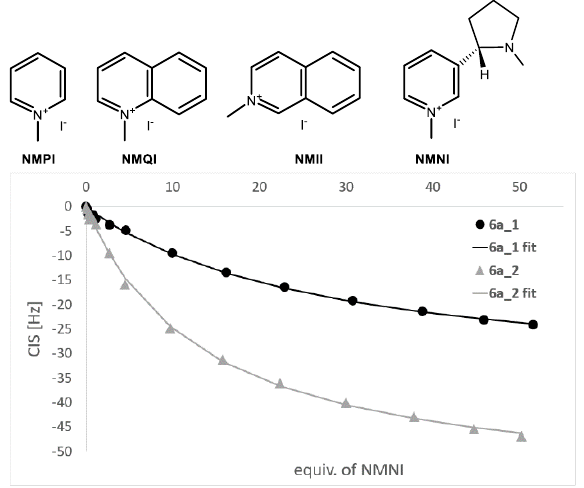
Figure 5. 1 H NMR titration curve of 6a_1 and 6a_2 with NMNI (C 2 D 2 Cl 4 , 400 MHz, 298 K), hydrogen in position 3- of calixarene quinoline moiety observed.